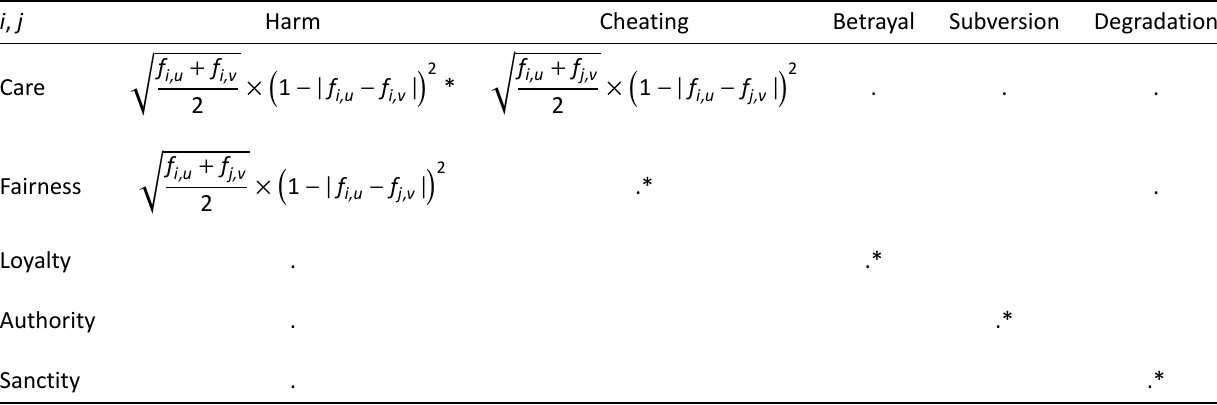
Loyalty . Authority . .* Sanctity . .* Note: Cells with * represent WFC, and the ones without represent